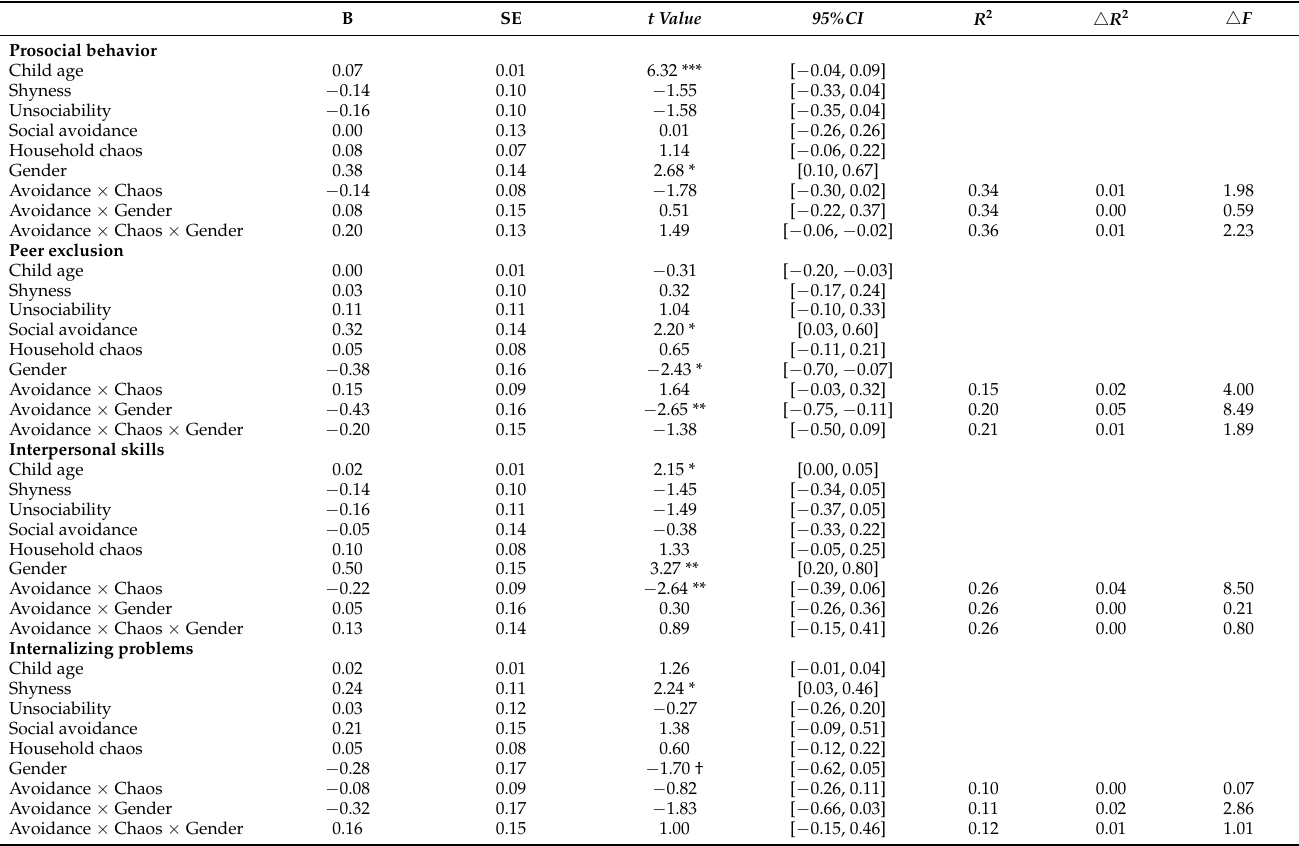
Table 2. Effects of social avoidance, household chaos, and gender in relation to indices of social